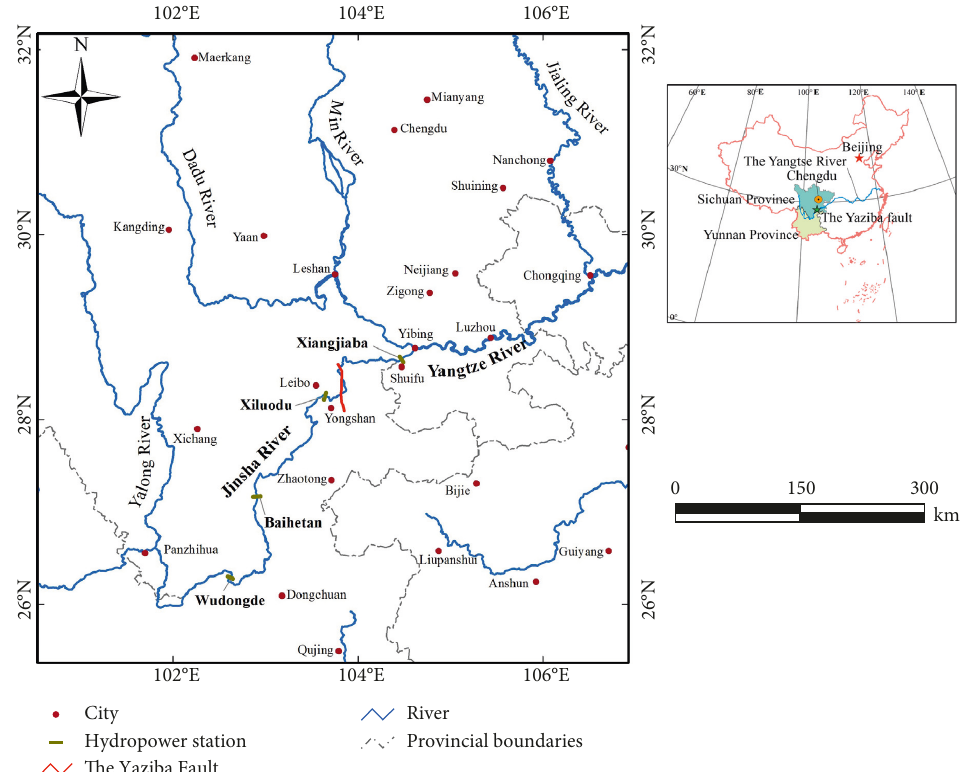
Figure 1: Map showing the location of the study